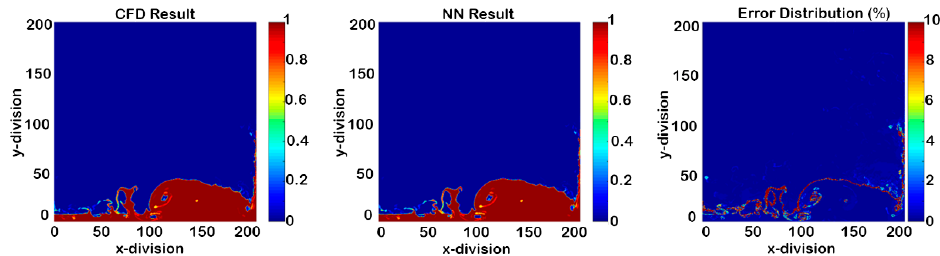
Figure 13. Phase fraction results in time-step 1151 (time-step size of 0.004 s).